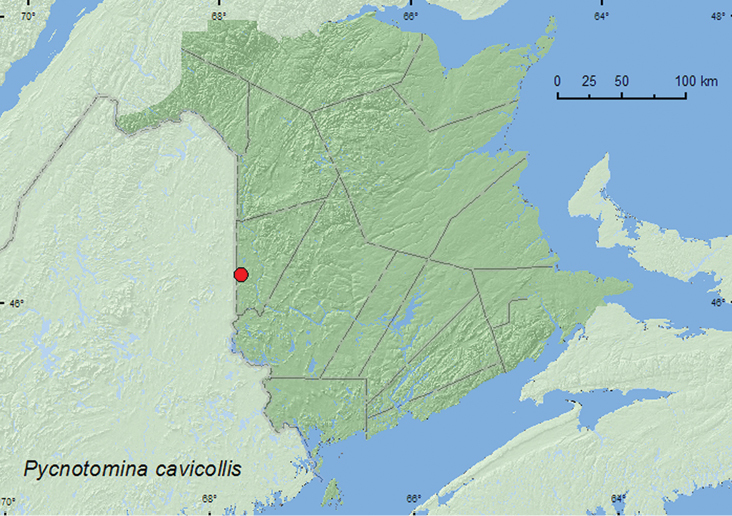
Collection localities in New Brunswick, Canada of Pycnotomina cavicolle.